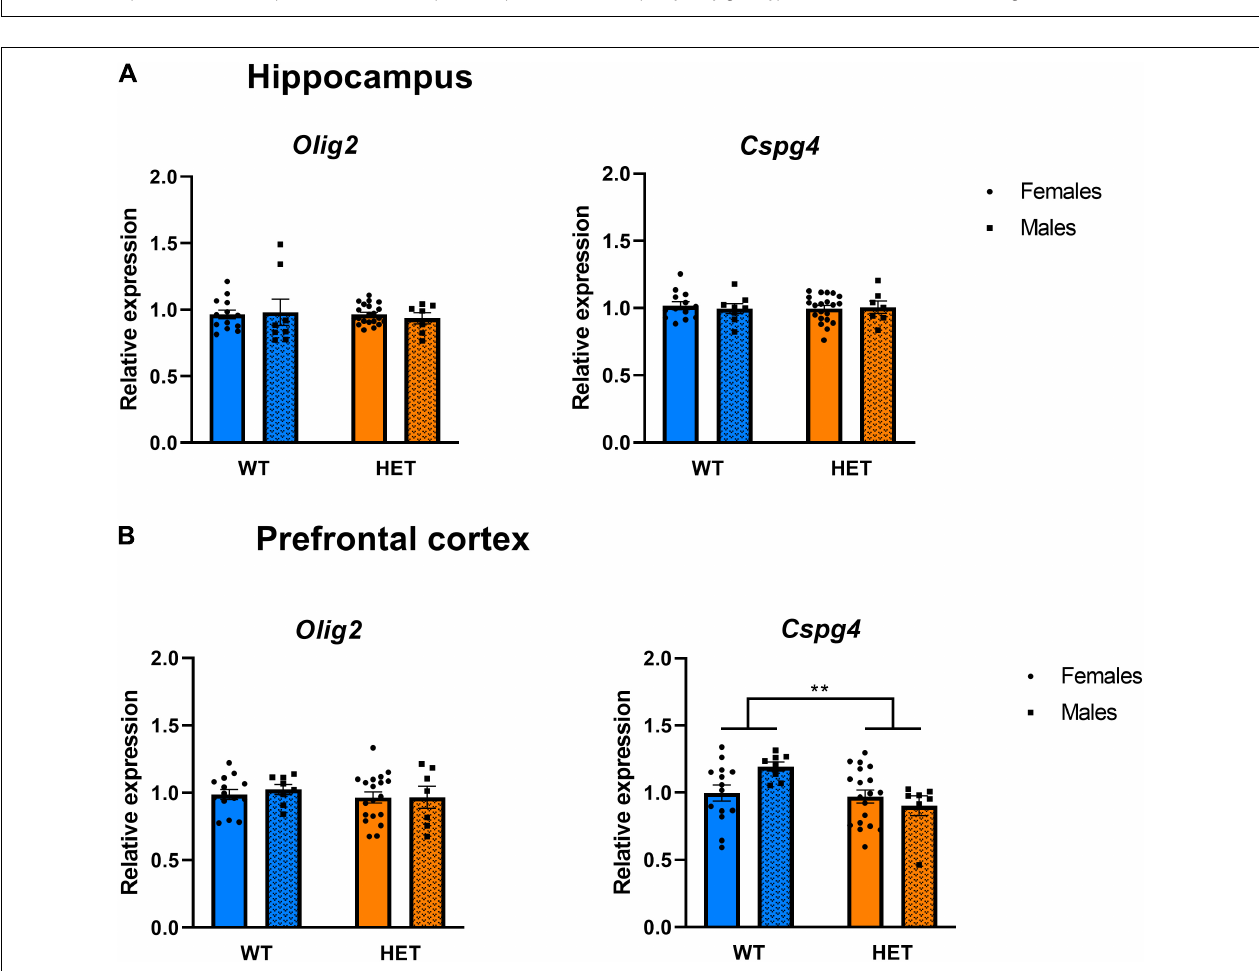
FIGURE 6 | Expression analysis of genes involved in the myelination process. (A) Relative mRNA levels of 7 myelination biomarkers in the hippocampus of St3gal3 mice (HET: n = 21, WT: n = 13). A trend toward a reduction of Mbp expression levels in females was observed (sex: F 1 , 43 = 3.671, p = 0.062). (B) Protein levels of the myelination markers MBP and PLP in the hippocampus of St3gal3 male mice (HET: n = 7, WT: n = 8). Representative blots are shown in each case. No differences were observed for any of the analyzed proteins. (C) Relative mRNA levels of 7 myelin biomarkers in the PFC of St3gal3 mice (HET: n = 19, WT: n = 14). A significant genotype effect on Plp2 levels was found (genotype: F 1 , 42 = 5.142, p = 0.0286). A trend toward a reduction of Plp1 expression levels in females (regardless from genotype) was also observed (sex: F 1 , 43 = 3.936, p = 0.0537). (D) Protein levels of the myelination markers MBP and PLP in the PFC of St3gal3 male mice (HET: n = 7, WT: n = 8). Representative blots are shown in each case. A significant reduction in MBP protein levels was observed in HET mice ( t = 2.411, p = 0.0409). qPCR data were analyzed by two-way ANOVA and presented as mean ± SEM. Western blot data were analyzed by Student’s t -test with Welch’s